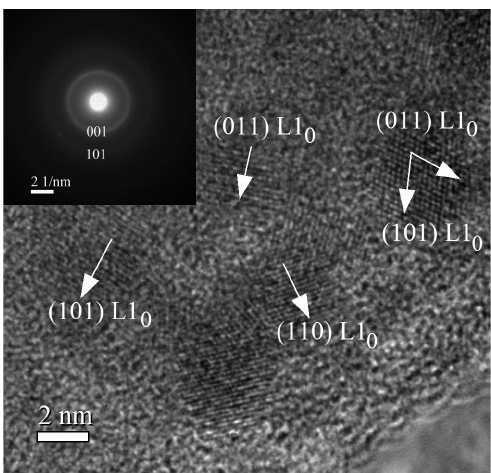
Figure 5. An area of the Co 48 Pt 28 Ag 6 B 18 sample annealed at 670 ◦ C showing L1 0 phase zones containing lattice planes of (101) and (110); Inset: the associated SAED pattern.